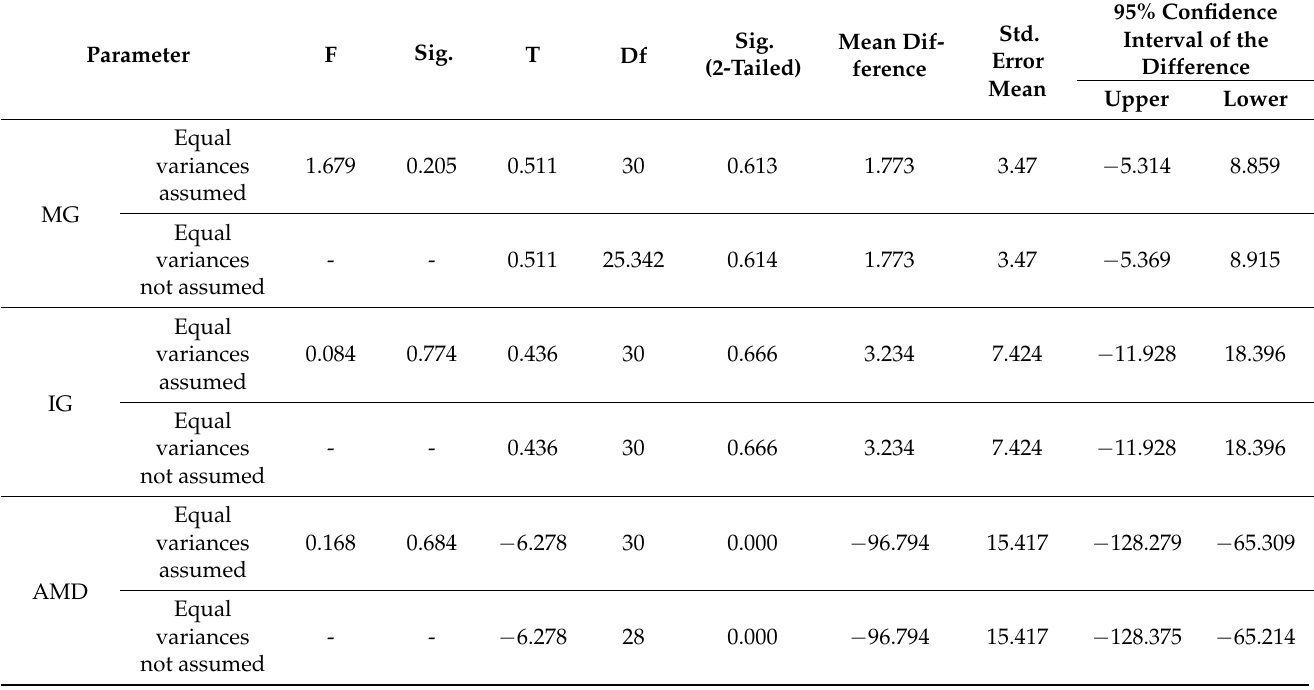
Table 3. Independent samples’ Student’s t -test comparing Zi and ZLS crowns for marginal gap, internal gap, and AMD (n =